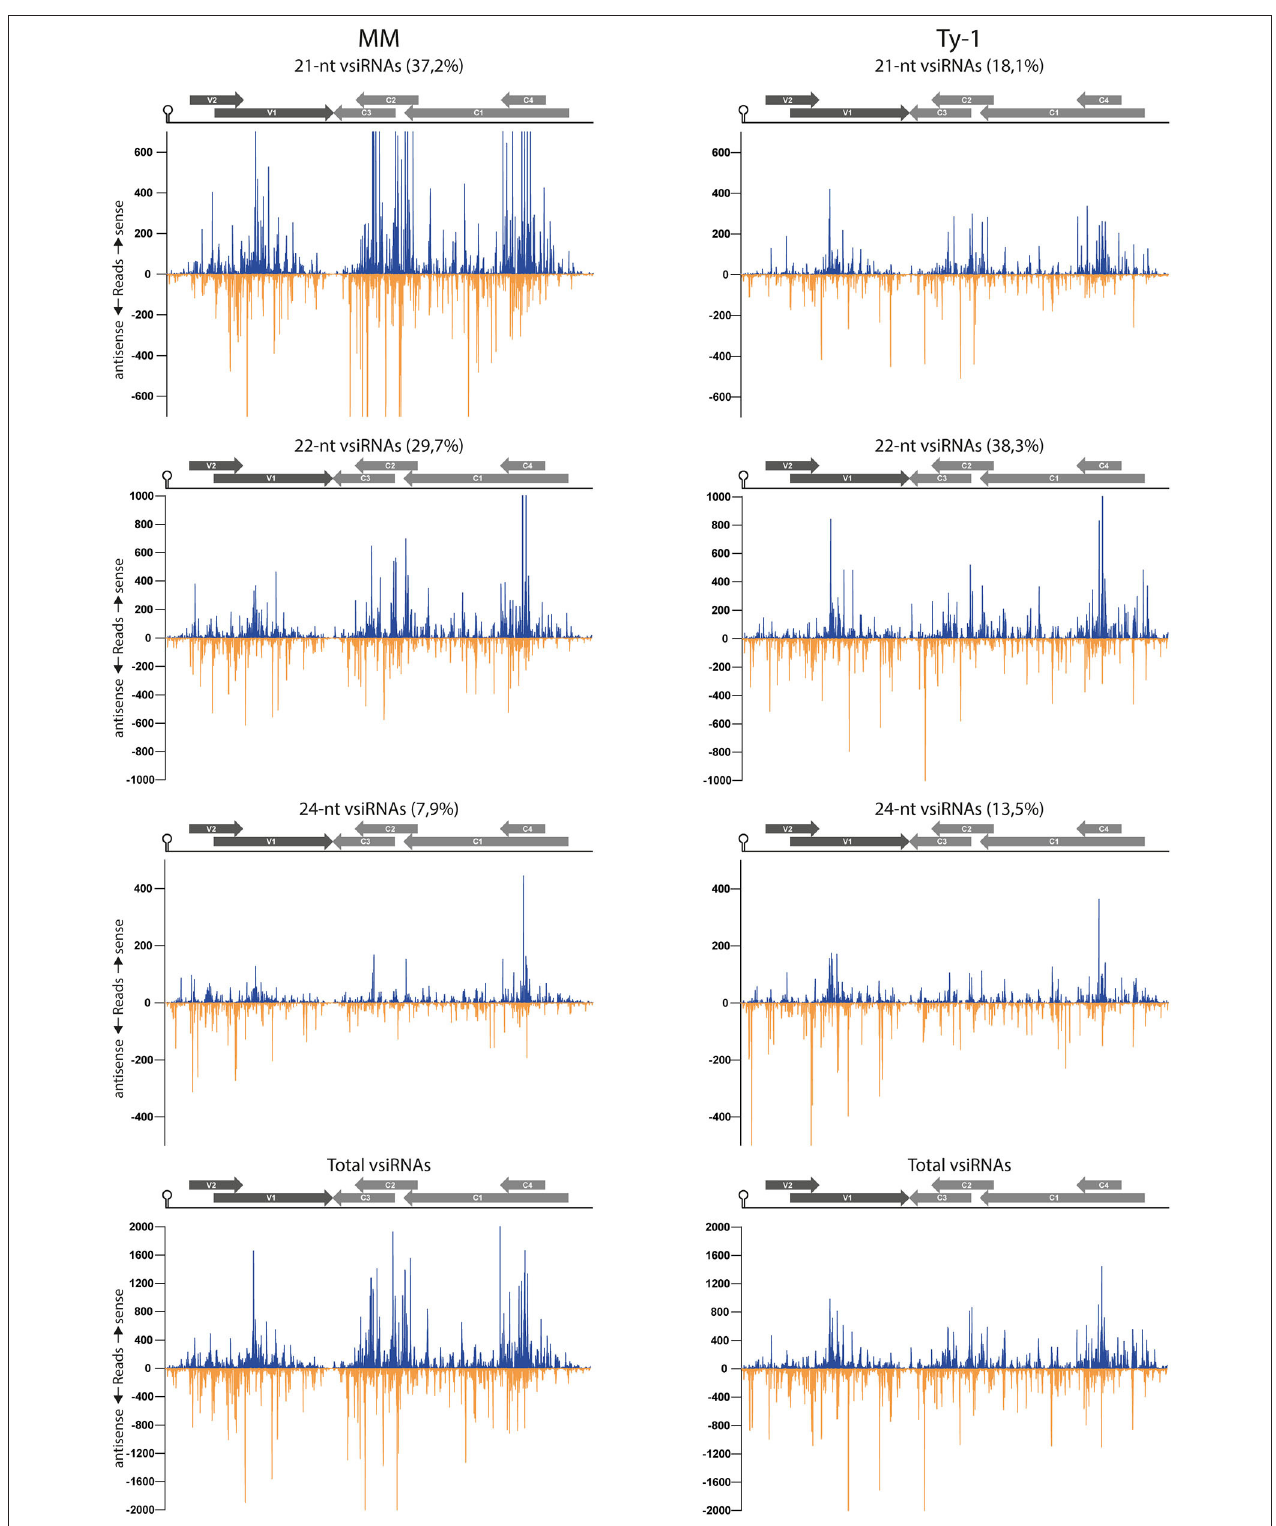
FIGURE 5 | Distribution of vsiRNAs on the TYLCV genome in MM and Ty-1 tomato. Viral siRNAs isolated from infected MM (left panel) or Ty-1 (right panel) tomato were mapped on the genome of tomato yellow leaf curl virus (TYLCV). The number of reads at each nucleotide position of the TYLCV genome is plotted (average